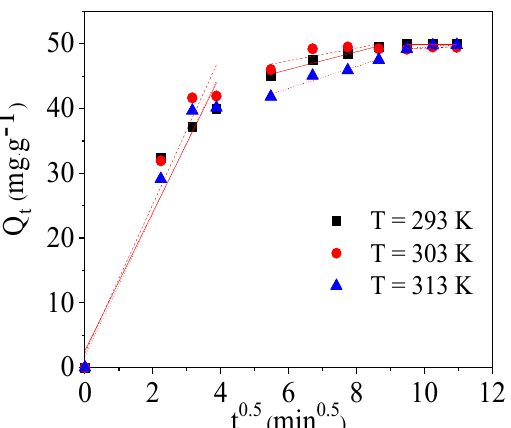
Figure 8. Internal diffusion model. ([Cr(VI)] = 25 mg/L, [nZVI] = 0.5 g/L, pH = 3, Time = 120 min).